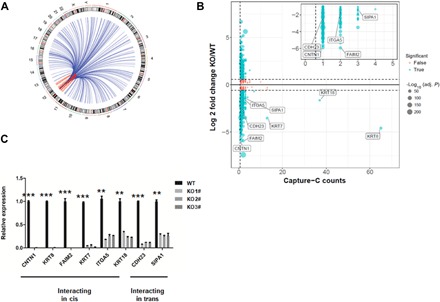
The rs55958994 risk enhancer is a hub for intrachromosomal and interchromosomal interactions.(A) Circos plot showing genome-wide interactions indicated by curves extending from the bait locus; intrachromosomal and interchromosomal interactions are in red and blue, respectively. Interactions reproducible in at least two biological replicates are shown. (B) A comparison of gene expression fold changes based on RNA-seq and the corresponding Capture-C signal counts are shown. A total of 2936 genomic loci with differential expression (adjusted P < 0.1) are shown on the plot. Among them, 219 loci with both reproducible interaction (Capture-C support > 1) and significant expression change between KO and WT (adjusted P < 0.1 and log 2 fold change > 1 or <−1) are shown in blue. (C) qRT-PCR analysis of mRNA (independent mRNA library) levels of potential target genes of the risk enhancer based on analysis in enhancer-deleted (KO) cells. Data represent means ± SEM of three independent experiments. ***P < 0.001, **P < 0.01 compared with corresponding KO cells.